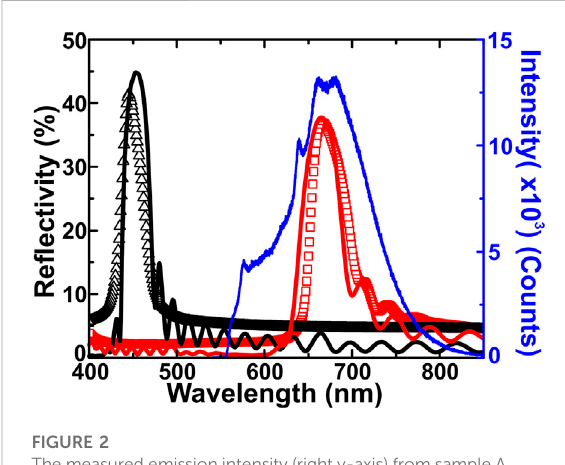
FIGURE 2 The measured emission intensity (right y-axis) from sample A (blue line) featuring ZPL and PSB of NV center. The simulated re fl ectivity (left y-axis) of sample A (black solid) and sample B (red solid) shows the stopgaps at 453 and 664 nm, respectively. The measured re fl ectivity of sample A (triangles) and sample B (squares) shows the stopgaps at 445 and 667 nm,